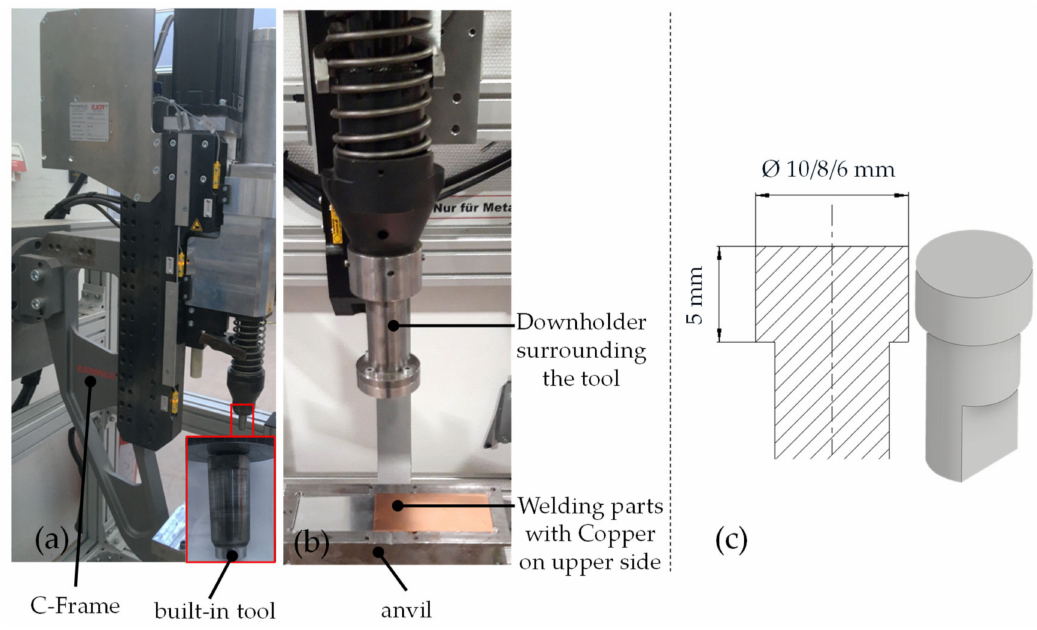
Figure 2. Welding setup with included welding parts ( a , b ) and geometry of the used pinless tools ( c ).